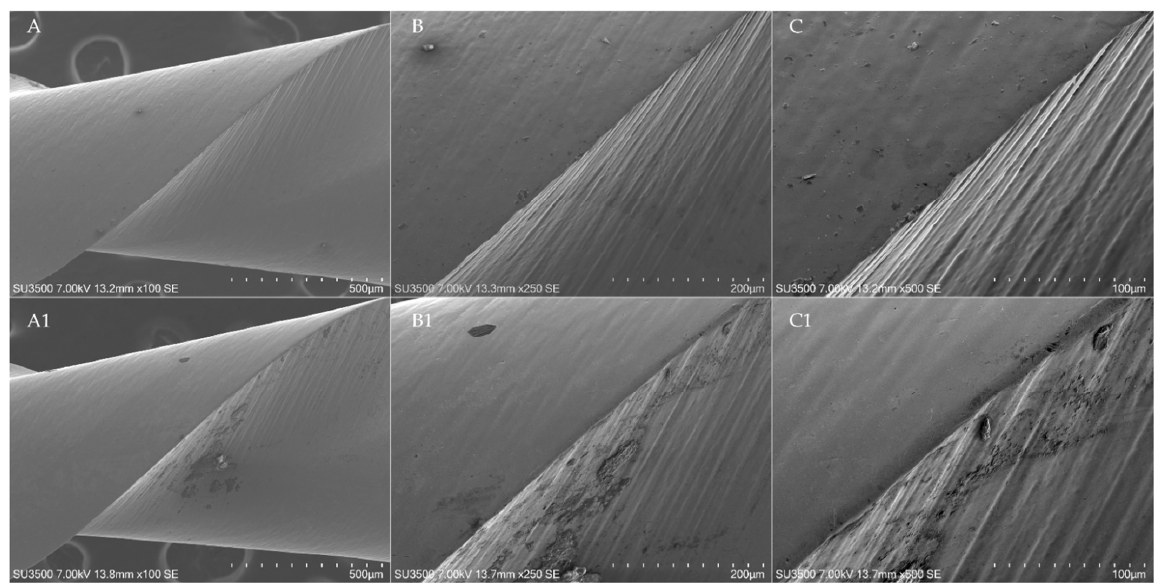
Figure 8. SEM images representing the moderate flattening of cutting edges of OR instrument after 4 simulated clinical uses at three different magnifications (from left to right respectively, of ×100, ×250 and ×500). ( A – C ) cutting edge of OR new instrument. ( A1 – C1 ) the same cutting edge of the